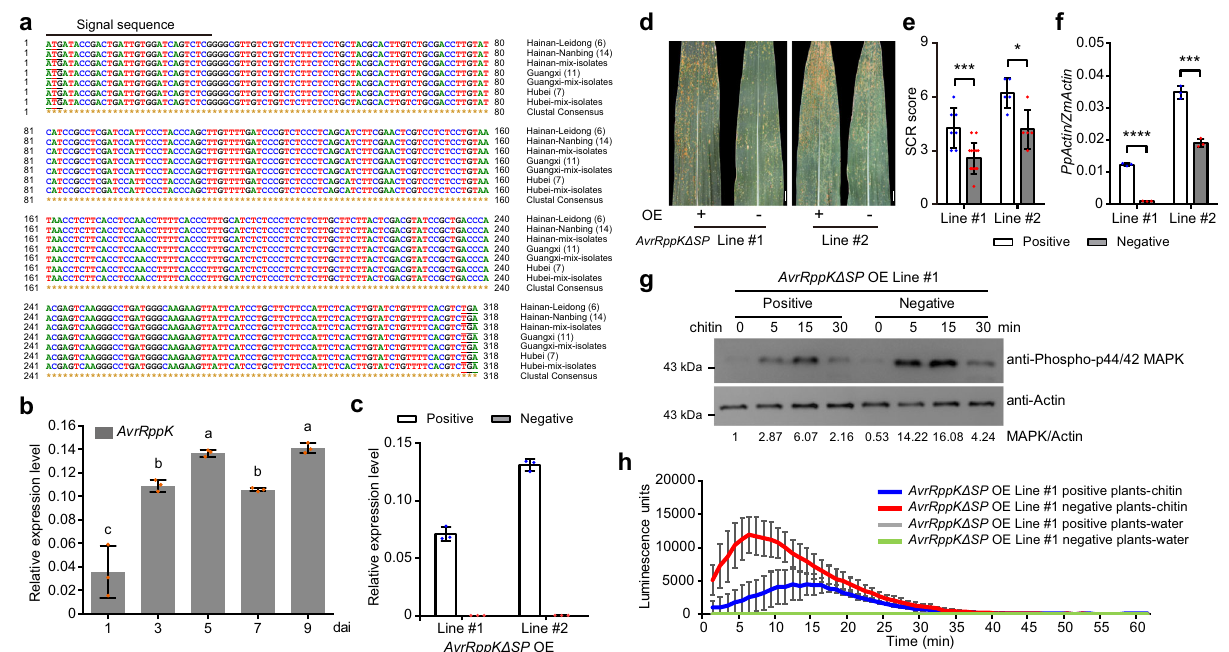
Fig. 4 | AvrRppK suppresses chitin-triggered immunity. a The AvrRppK gene is conserved in all tested P. polysora fi eld isolates. DNA samples were isolated from twenty P. polysora isolates from Hainan, eleven isolates from Guangxi, six isolates from Hubei and mixed spores collected from Hainan, Guangxi and Hubei, respec- tively; b Theexpressionlevelof AvrRppK duringinfection.Five-leafstageB73plants were inoculated with conidia of the P.polysora Wuhan strain.Leafsamples takenat 1, 3, 5, 7, and 9 days after inoculation (dai) were used for RT-qPCR to evaluate the expression levels of AvrRppK relative to those of the P. polysora Actin gene. Values aremeans±SDs ( n =3repeats). One-way ANOVA with Fisher ’ s LSDtest(mean±SD; n =3, biologically independent samples). Different letters indicate signi fi cant dif- ferencesat P <0.05. c Thetrans c riptionlevelsof AvrRppK Δ SP measuredbyRT-qPCR in two independent transgenic maize lines overexpressing AvrRppK Δ SP ( n =3). d The SCR disease phenotypes of two independent transgenic maize lines over- expressing AvrRppK Δ SP . “ + ” meanstransgenic-positiveplants, “ - ” meanstransgenic-